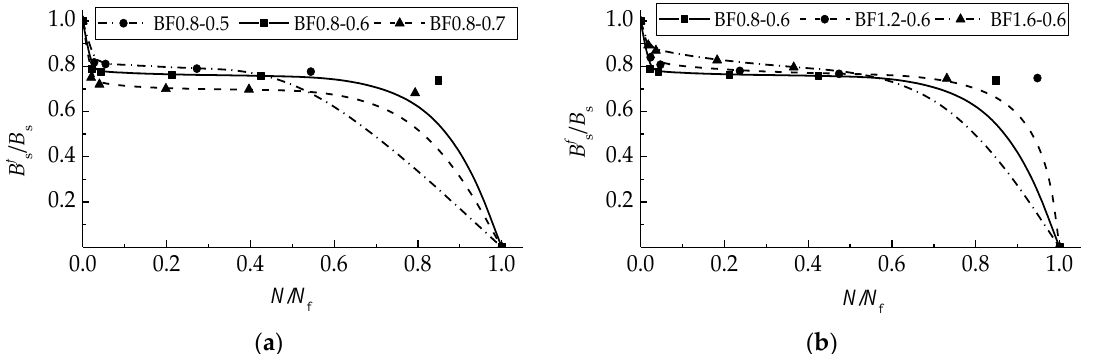
Figure 10. Relative stiffness degradation curve of beam affected by: ( a ) α h ; and ( b ) v f .